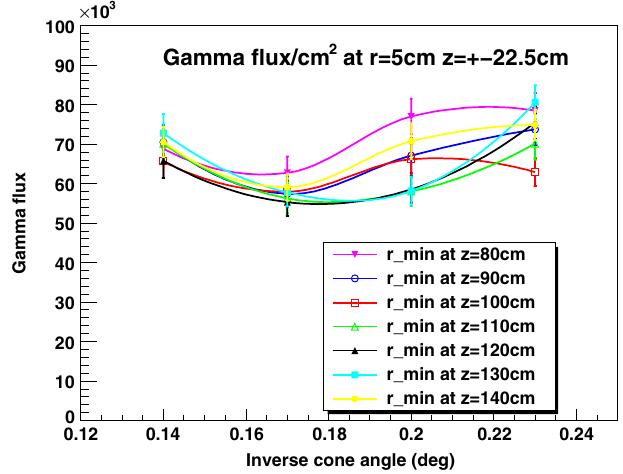
FIG. 9. Gamma flux vs inner cone angle at different positions of minimal aperture from